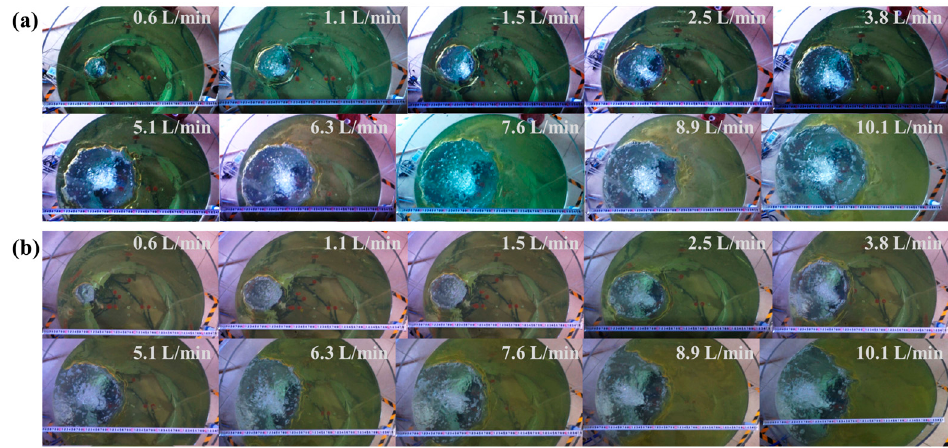
Figure 4. Flow field display diagram of single hole 2 ( a ) and 3 ( b ) at 7.6 L/min blowing rate.